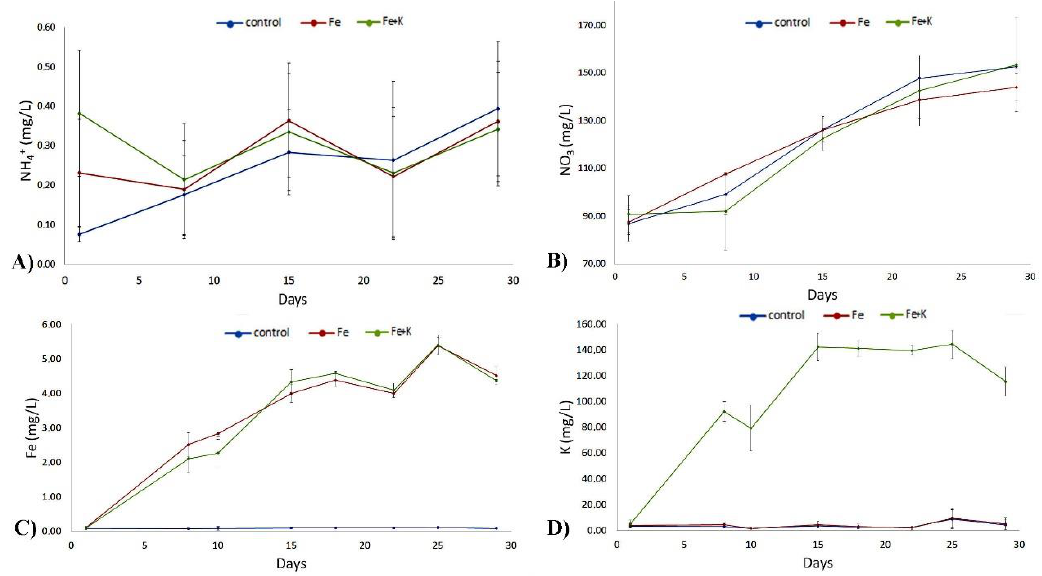
Figure 2. The fluctuation of ( A ) NH 4+ , ( B ) NO 3 − , ( C ) Fe, and ( D ) K in the inlet point of the hydroponic tank of the various treatments during the experimental period. Data are expressed as mean ± S.E.M ( n = 3).